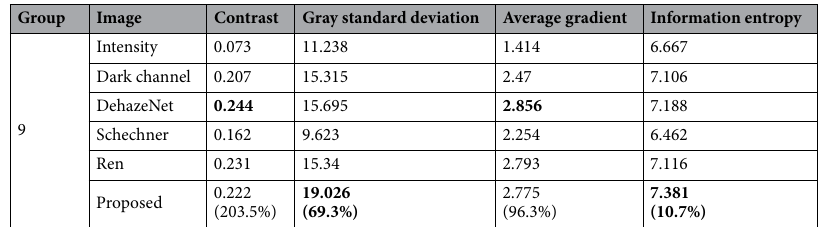
Table 1. Objective evaluation indexes of images. The bold data indicates the maximum value of every